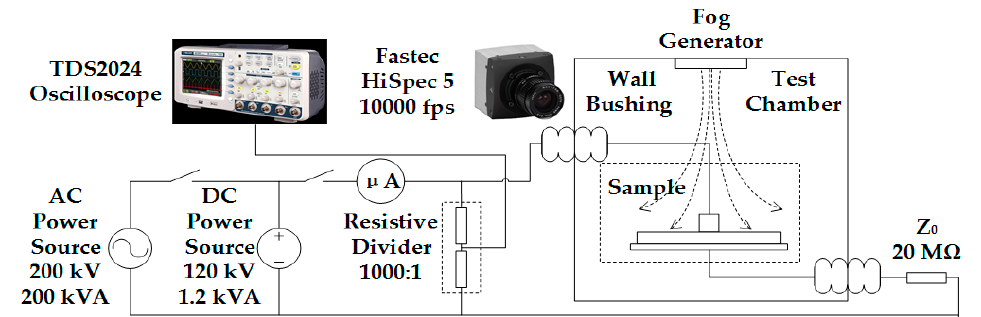
Table 1. The parameters of the suspension insulators. Insulator Type